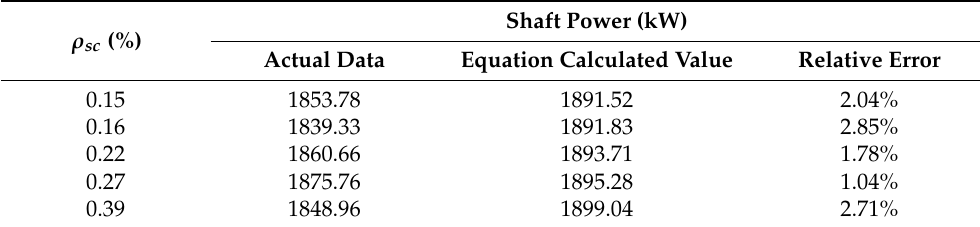
Table 5. Errors between actual data of shaft power and calculated values of shaft power equation at 0.8 Q working